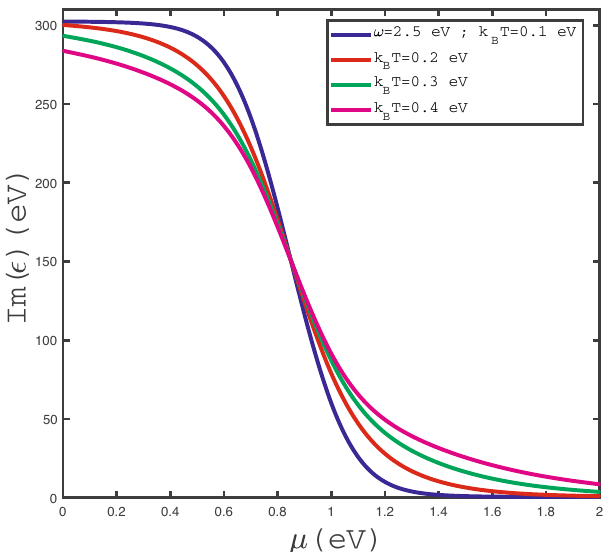
Figure 5. Optical absorption, Im (ǫ) , of doped MoS 2 layer as a function of chemical potential µ at fixed 2.5 eV for different values of temperature, namely k frequency ω = absence of strain.